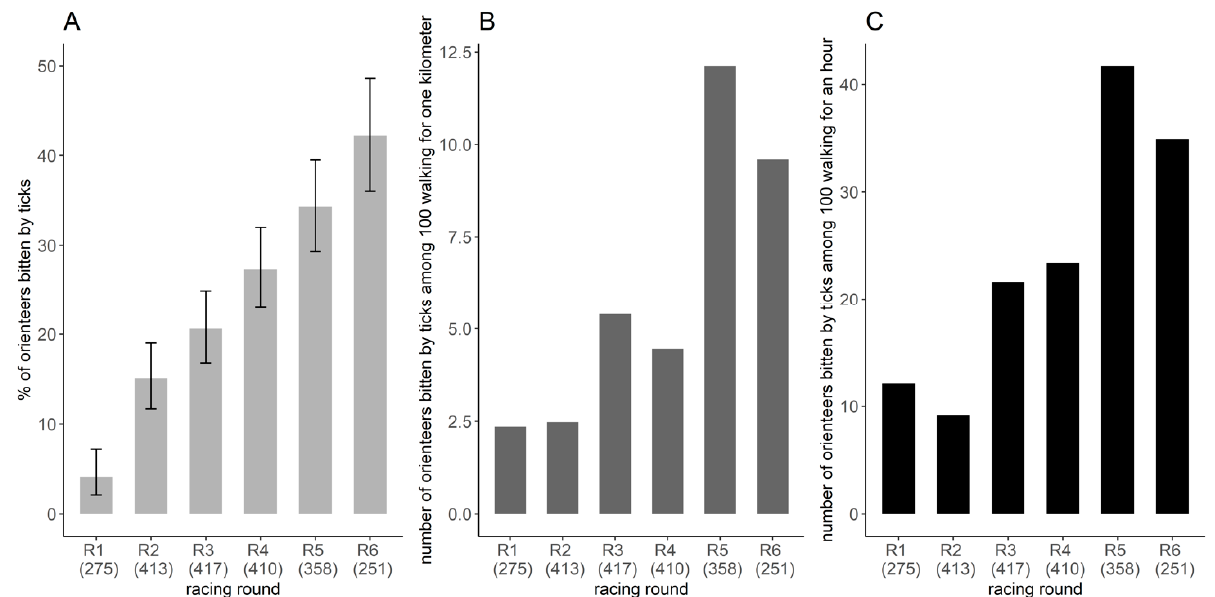
Figure 4. Frequency of tick bites per racing round. ( A ) Proportion of orienteers bitten by ticks per racing round and its 95% confidence interval, estimated by the number of orienteers reporting tick-bites on the banner divided by the number of orienteers reporting on the banner, considering only the orienteers that participated four times or more (restricted banner dataset). Space–time exposure index of the number of orienteers bitten by ticks among 100 orienteers walking ( B ) one kilometer or for one hour ( C ). The number in parentheses represents the number of orienteers participating in the study.